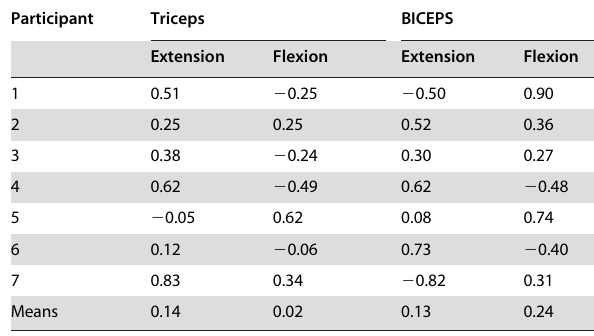
Table 2. Correlation coefficients between rms EMG